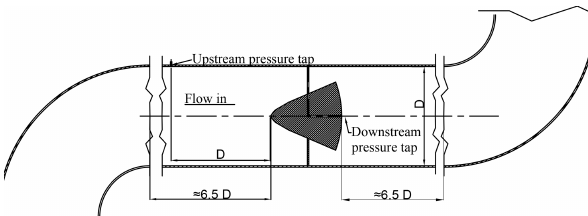
Figure 5. Schematic view of the installed P-G